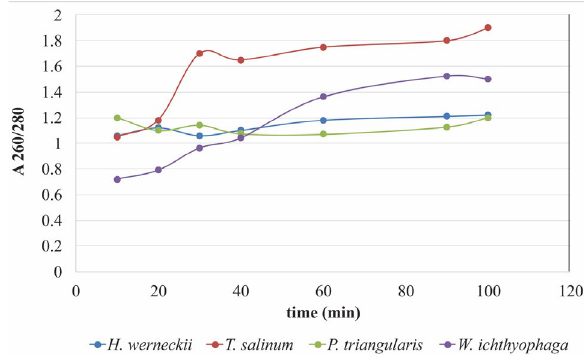
Figure 3: Residual total protein concentration in halophilic fungi cell suspensions in relation to homogenization time at 35 °C and a ho- mogenization speed of 25,000 rpm. Experiments were repeated three times. Standard deviation for all measurements was less than ± 3%.